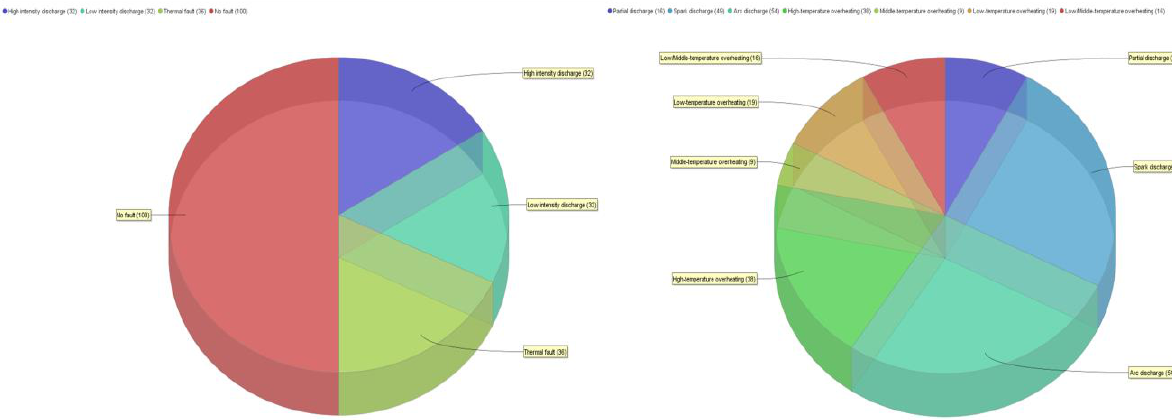
Figure 10. Dataset failures labels.